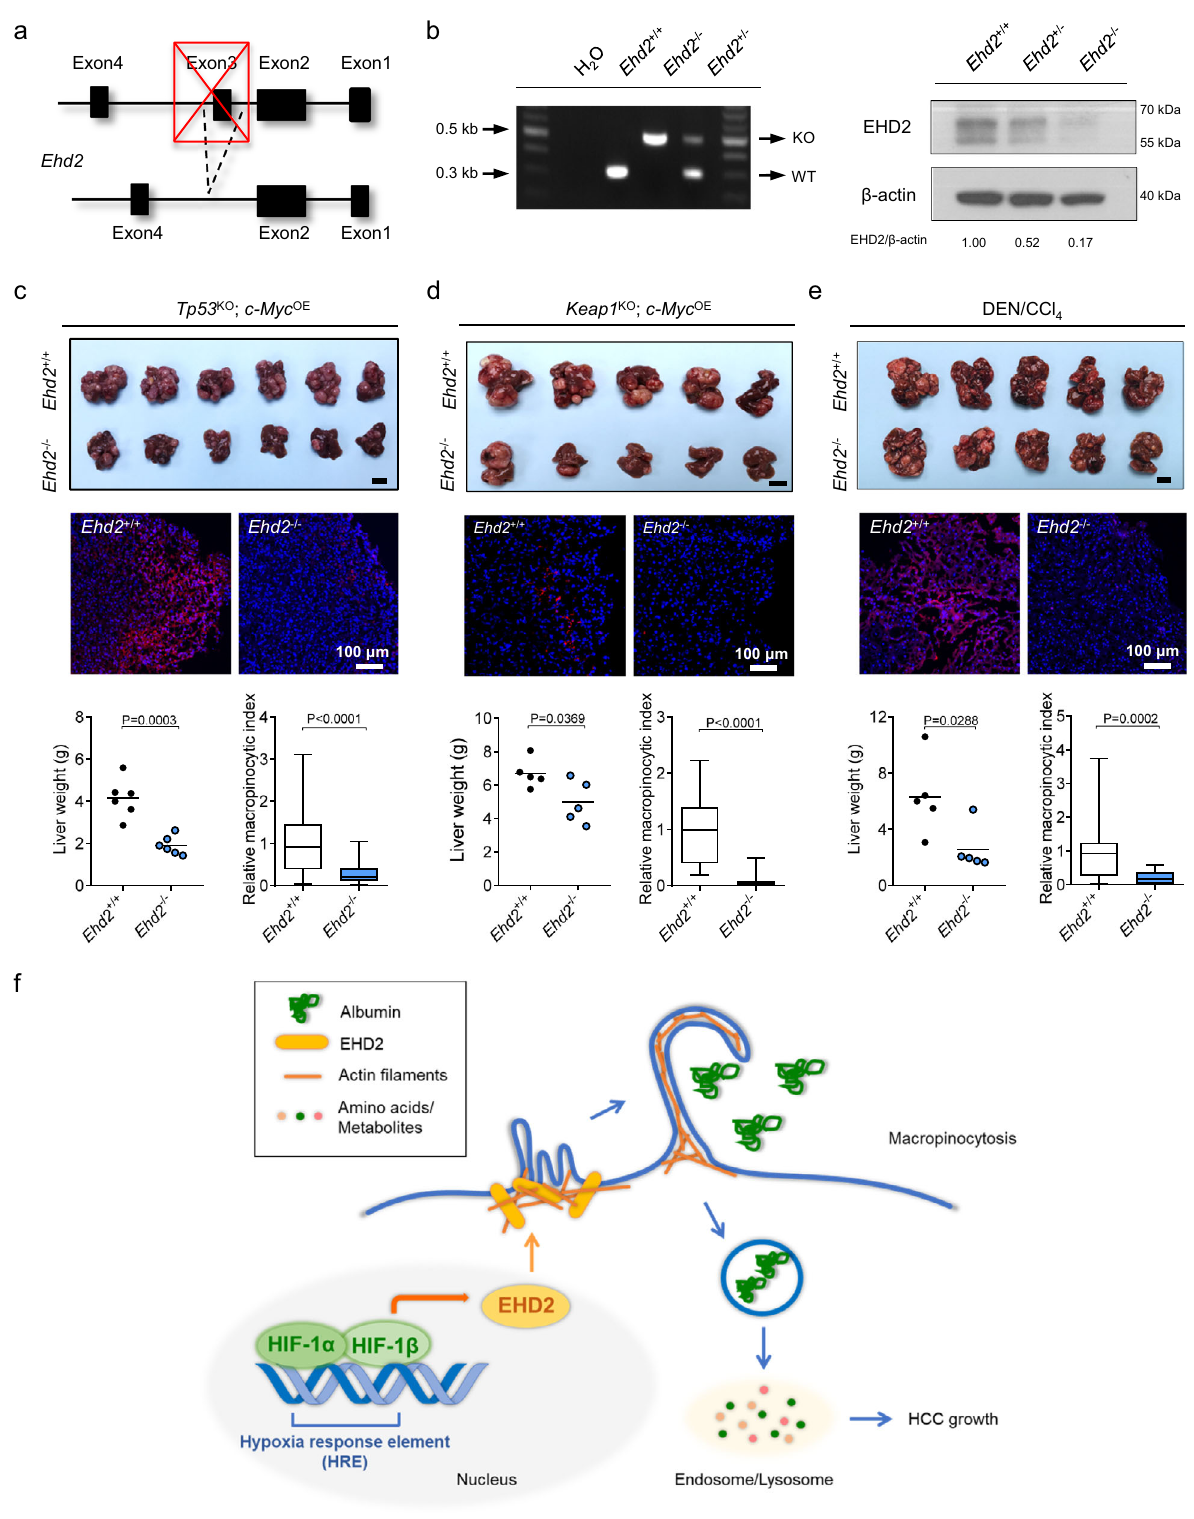
under nutrient-insuf fi cient condition (10% amino acid compar- ing with normal culture media, 10% AA) in the presence of BSA (Supplementary Fig. 18a). Consistently, OE of EHD2 did not affect proliferation of hypoxic HCC cells but signi fi cantly increased proliferation of hypoxic HCC cells